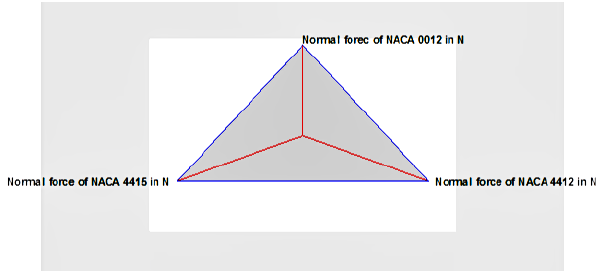
Figure 15. Normal force representation for three NACA